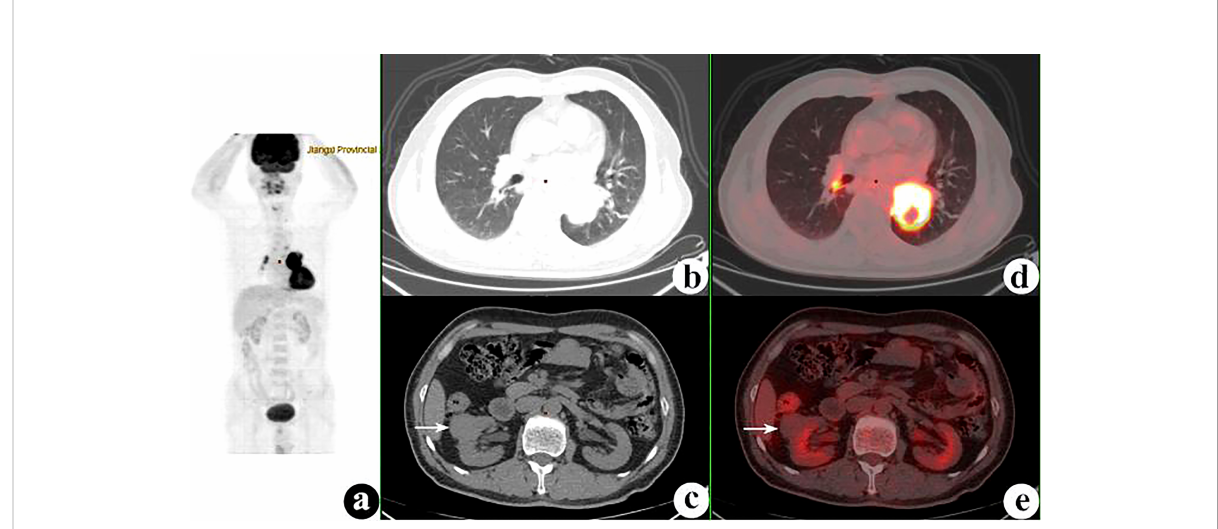
FIGURE 2 18 F- fl uorodeoxyglucose positron emission tomography/computed tomography ( 18 F-FDG PET/CT) of a 54-year-old man with lung squamous cell carcinoma and renal small cell carcinoma. PET/CT demonstrated a 52 × 47-mm mass with a maximum standardized uptake value (SUV max ) of 15.5 in the left lower lung and a 30 × 30-mm nodule with SUV max of 1.1 ( white arrows ) in the right kidney. Several hilar and mediastinal lymph nodes with different FDG uptake levels were proven to be hyperplasia. (A) PET maximum intensity projection (MIP). (B, C) Axial CT. (D, E) Fusion